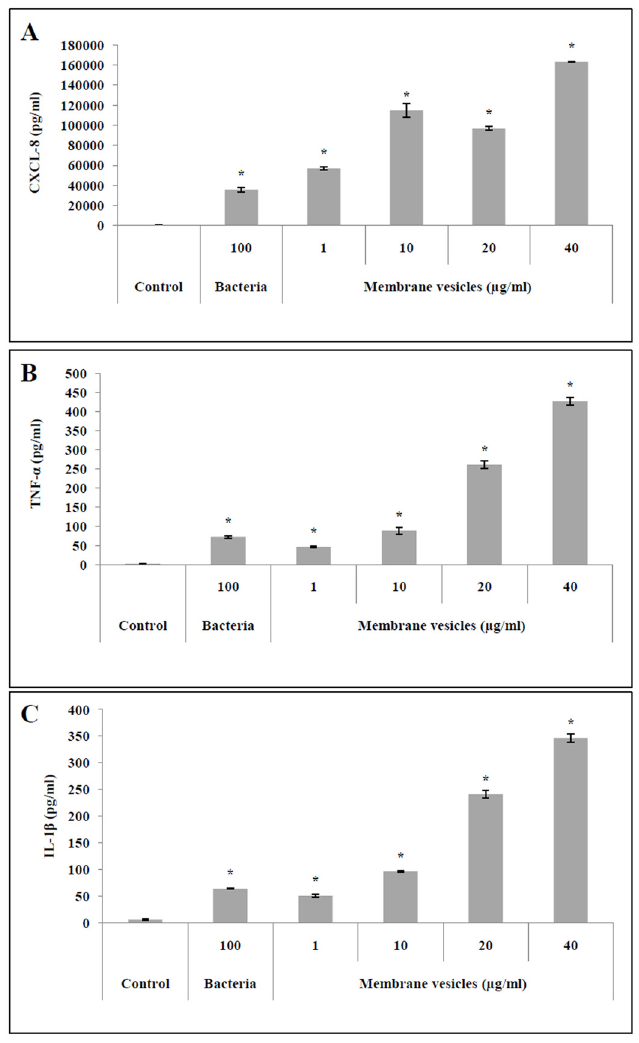
Fig 6. Quantification of CXCL-8 (A), TNF- α (B), and IL-1 β (C) secretion by macrophage-like cells stimulated with S. suis membrane vesicles (1 to 40 μ g/ml), E. coli LPS (10 μ g/ml), and S. suis P1/7 whole bacteria (MOI = 100). Results were considered significant at * p < 0.05 compared to unstimulated